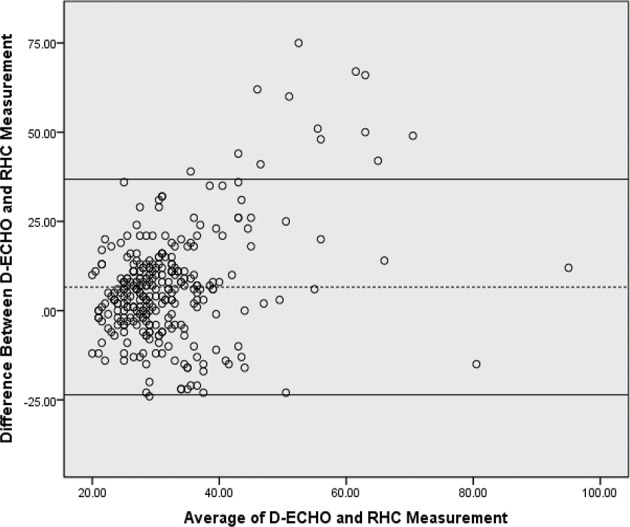
Bland-Altman plot of sPAP estimated by Doppler echocardiographic and RHC. The bias was 6.6 mmHg and the 95% limits of agreement were 23.6–36.8 mmHg. Dotted line, bias; solidline curve, upper and lower limits of agreement. D-ECHO, Doppler echocardiography; sPAP, pulmonary artery systolic pressure; RHC, right-heart catheterization.